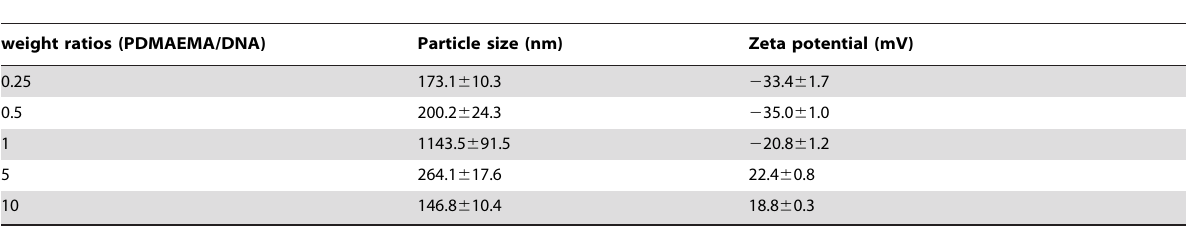
Table 1. Particle sizes and Zeta potentials of PDMAEMA/DNA nanoparticles with different weight ratios.